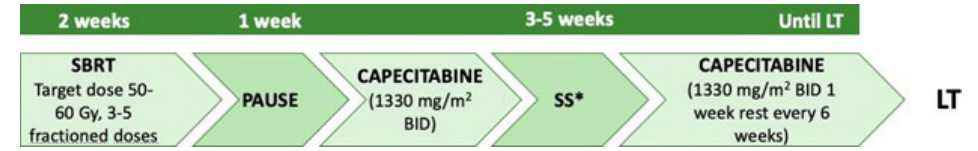
Figure 4. Toronto neoadjuvant protocol. Hf-EBRT: hyperfractionated external beam radiotherapy; mCT: maintenance chemotherapy; SS: staging surgery (either laparotomy or laparoscopic); LT: liver transplant; BID: twice a day. * with biopsies of hepatic artery and hepatoduodenal lymph nodes.